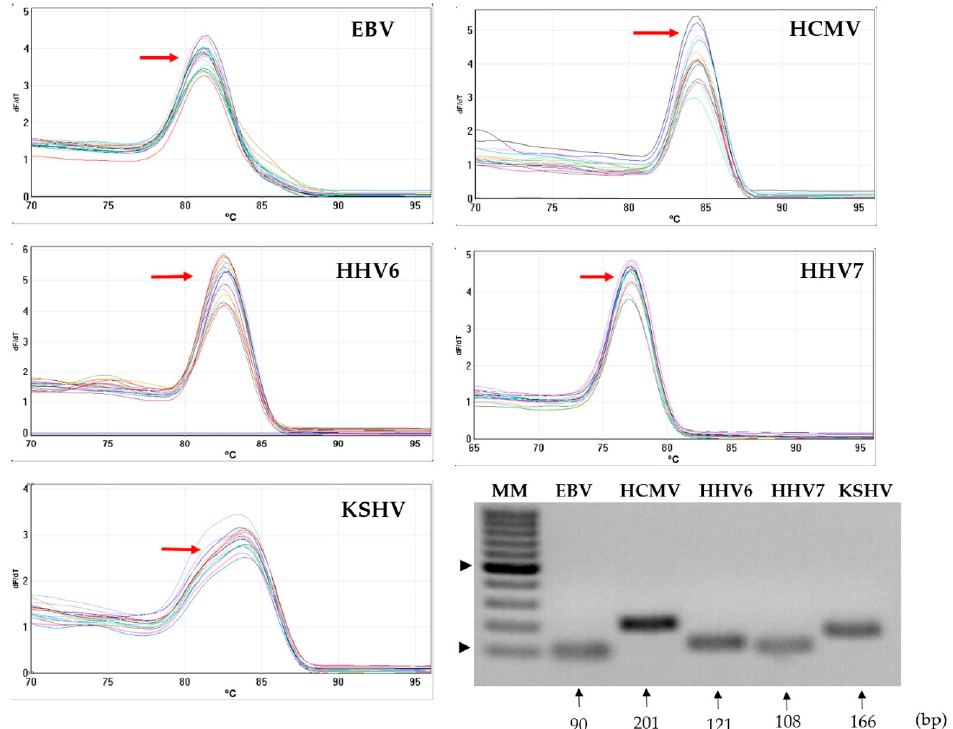
Figure 1. Assessment of specificity of primers in a human DNA background. MELT curves from each Sybr Green-based PCR detected the indicated virus. A single peak of dissociation (red arrow) was observed from each individual reaction ran in the presence of human genomic DNA from the MOLT3 cell line. Agarose gel electrophoresis (bottom right) showed that a unique PCR product of the expected size was amplified in each individual Sybr green-based PCR. MM: 100 bp (base pairs) molecular weight marker. Black arrowheads point at bands corresponding to 100 bp and 500